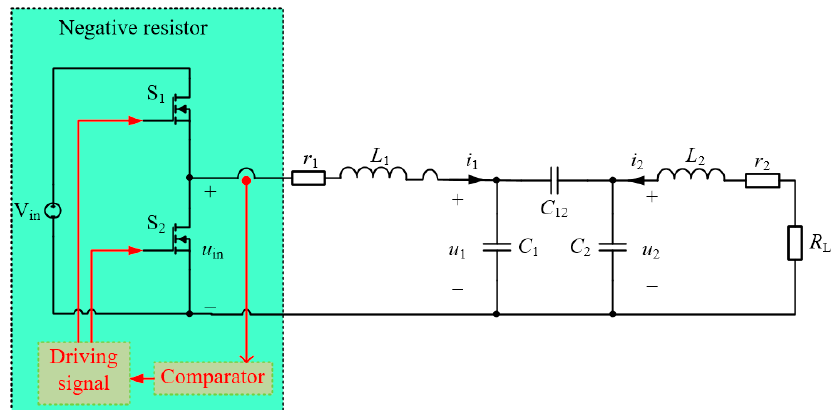
Figure 2. Equivalent circuit topology of a half ‐ bridge type single ‐ wire ECPT system.